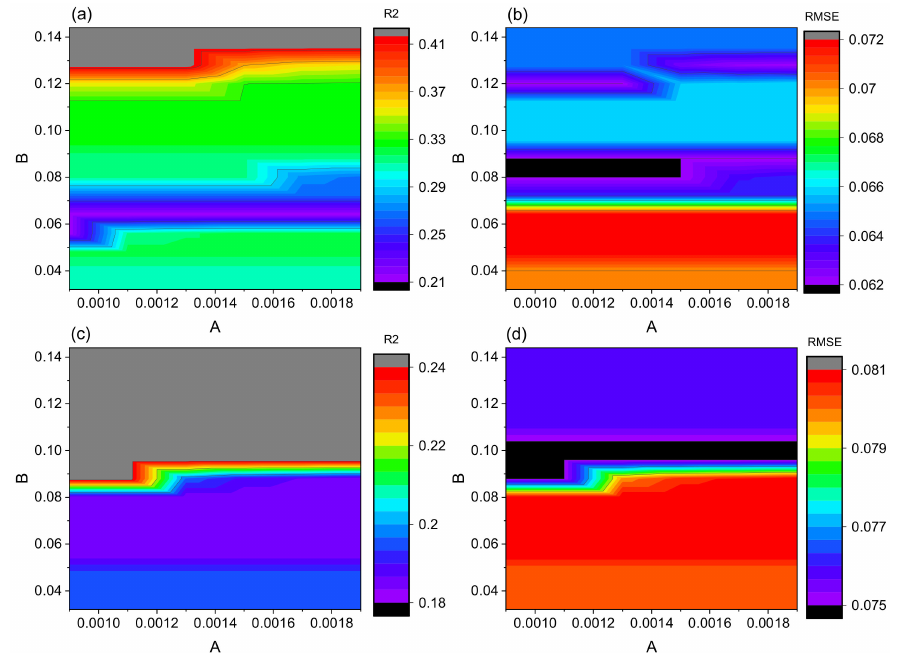
Figure 6. Error metrics of soil moisture retrievals from SCA-VH scheme under di ff erent parameter settings. ( a , b ) show the R 2 and RMSE of soil moisture retrievals at the COSMOS029 site, while ( c , d ) show the R 2 and RMSE of soil moisture retrievals at the COSMOS099